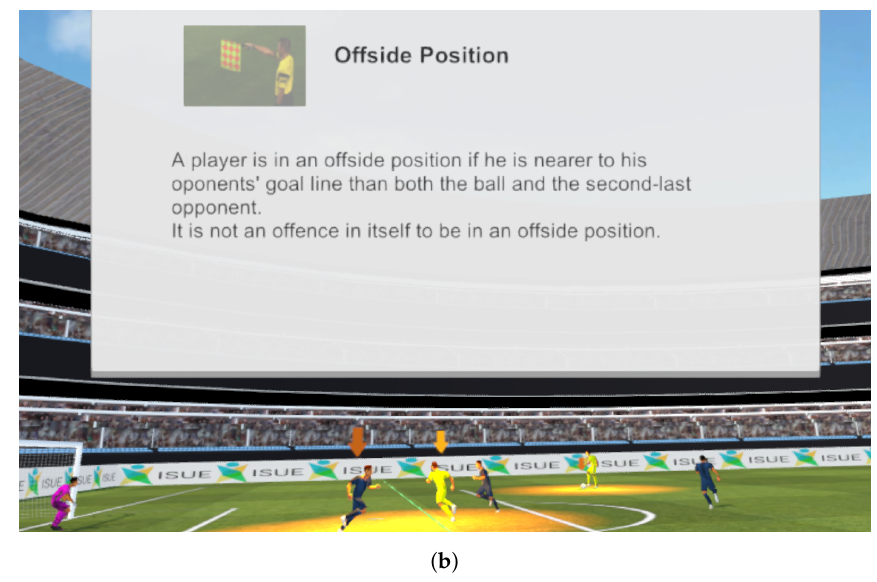
Figure 3. ( a ) Picture taken from HoloLens about the offside rule, visualization is presented to the user and explained with text, animations and visual cues superimposed on the real environment. Users can see just a limited area of this screen-shot. Red rectangle shows a rough view of the visible area; ( b ) Image taken from Vive application showing content about Offside position explained in a virtual soccer stadium.